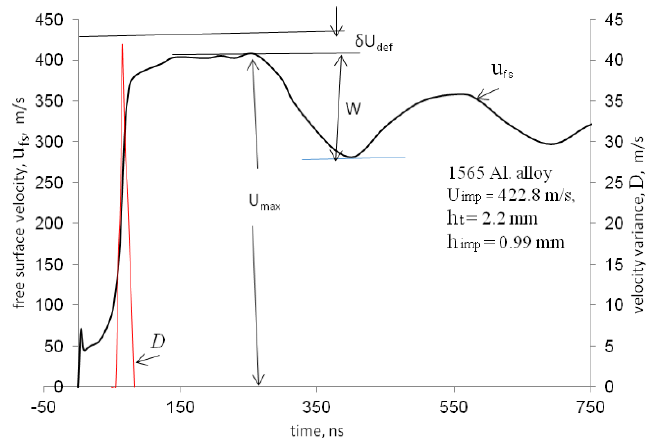
Figure 1. Free surface velocity profile, ufs(t), and velocity variance profile, D(t), for 1565 aluminum alloy target of 2.2 mm thickness loaded at the impact velocity 422.8 m/s.